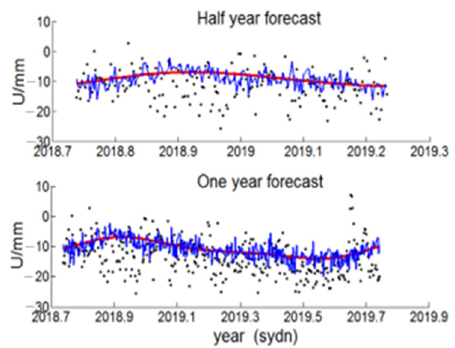
◆ elevation true value nonlinear elevation prediction value elevation prediction value based on GARCH Figure 14. Prediction of four CORS station elevations based on GARCH nonlinear velocity field. Table 10. Comparison of RMSE accuracy of elevation modeling predictions of four CORS stations (mm). Method of Pre- diction